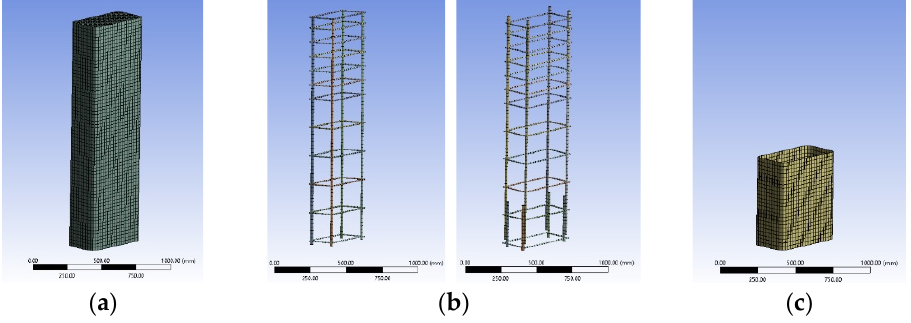
Figure 1. Parts of FE model ( a ) concrete, ( b ) internal (steel) reinforcement, ( c ) external reinforcement (FRP jacket).